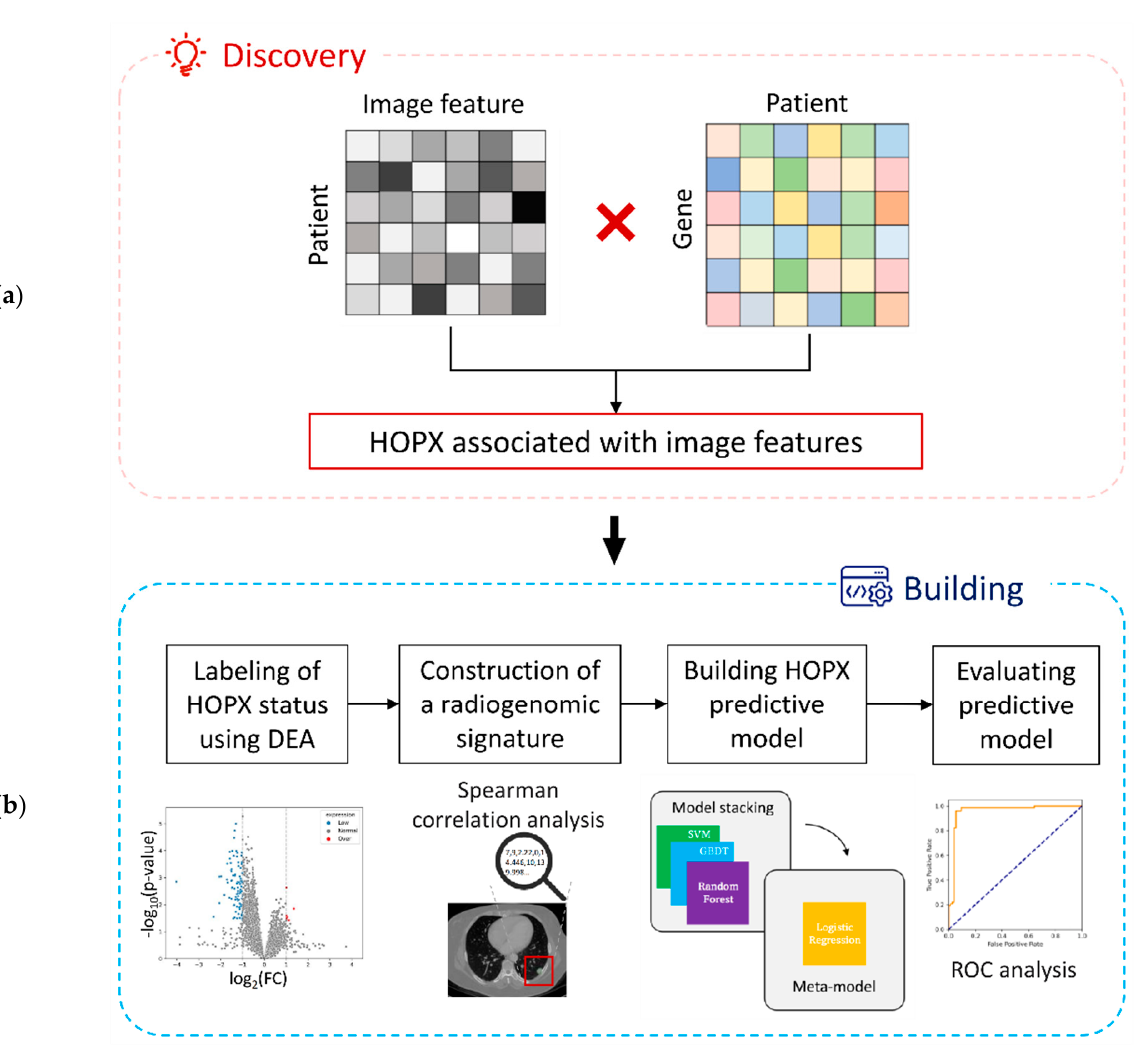
Figure 1. A workflow of this study: ( a ) a discovery step of image-associated genes and ( b ) a building step of an HOPX predictive model.